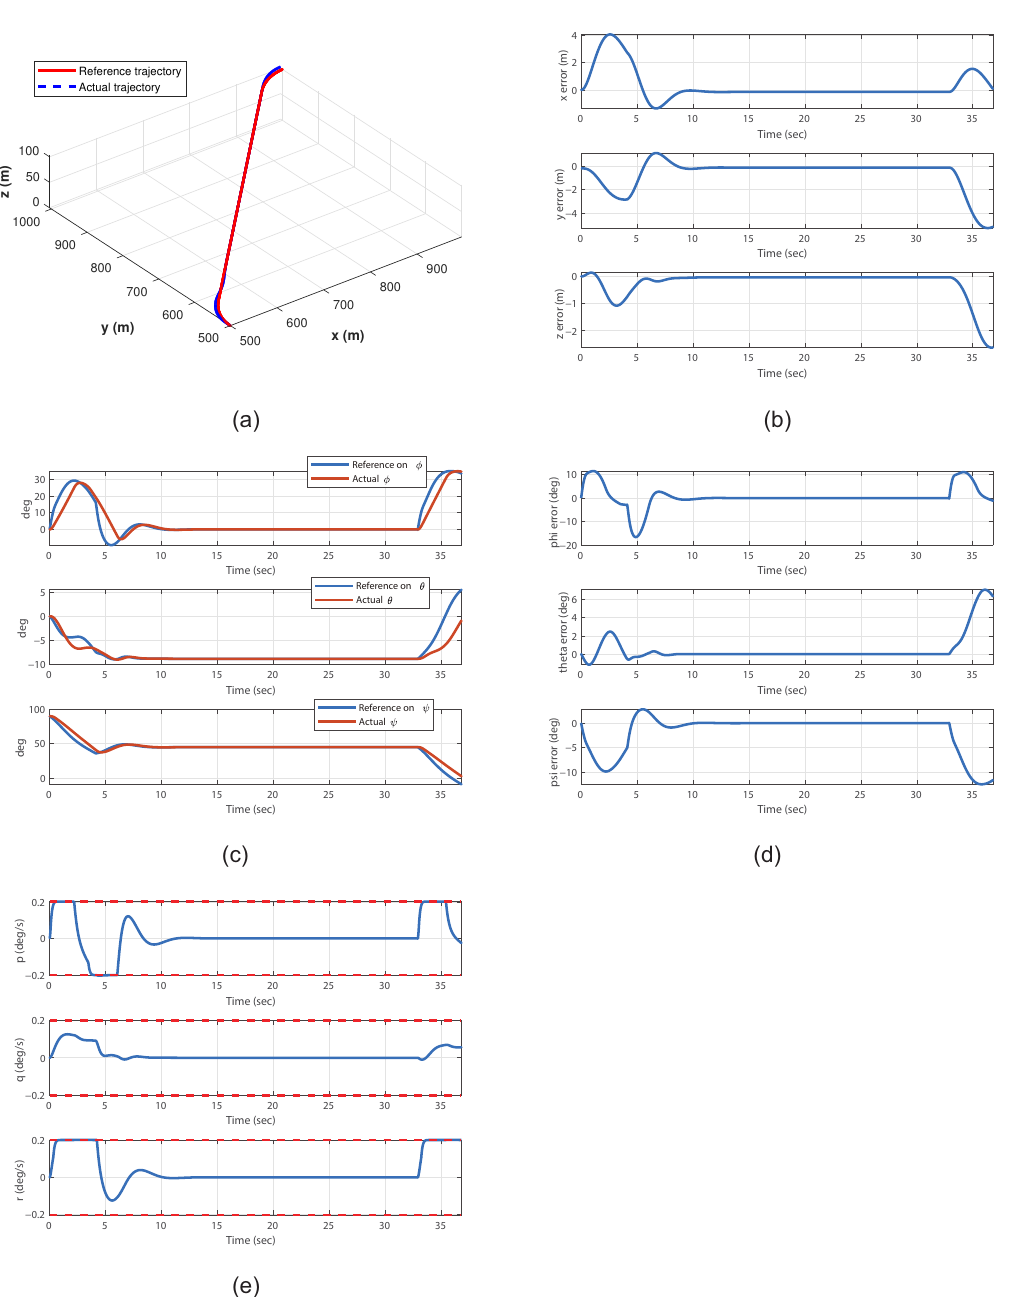
Figure 13. Path tracking results of no obstacles: ( a ) Path tracked in 3D. ( b ) Position error. ( c ) Attitude. ( d ) Attitude error. ( e ) Constrained angular